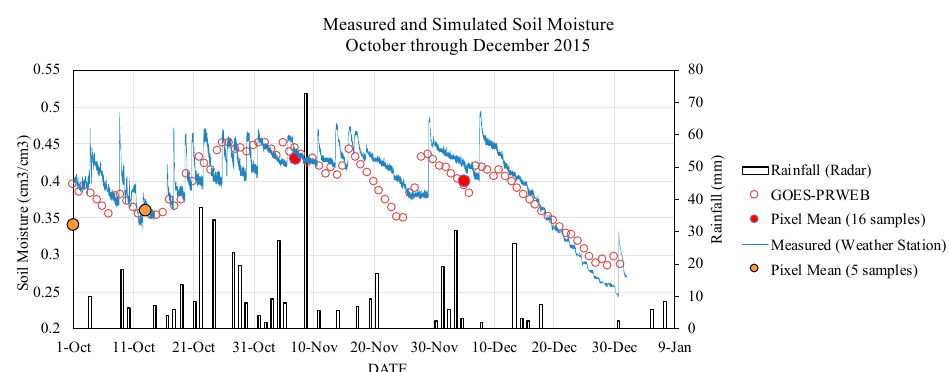
Rainfall (Radar) Rainfall (Radar) GOES-PRWEB Pixel Mean Measured (Weather Station)